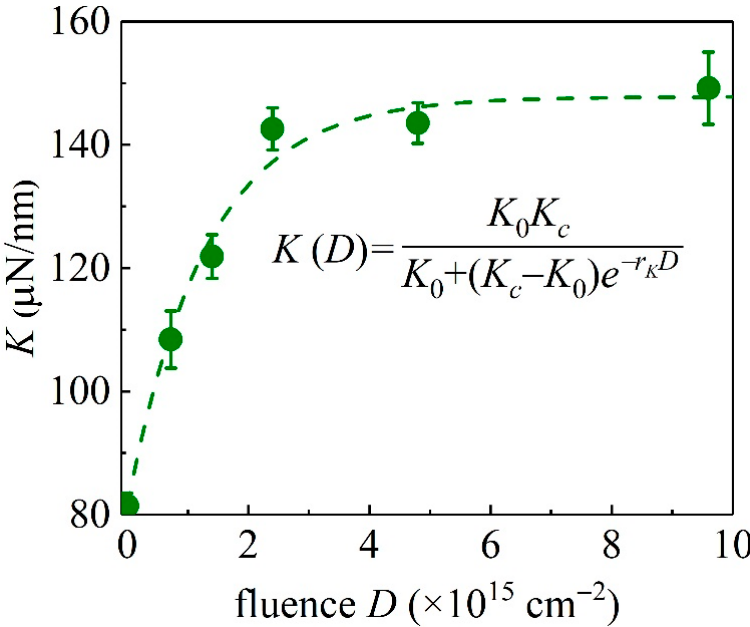
Figure 6. K values of GaN single crystal samples as a function of ion fluence D .